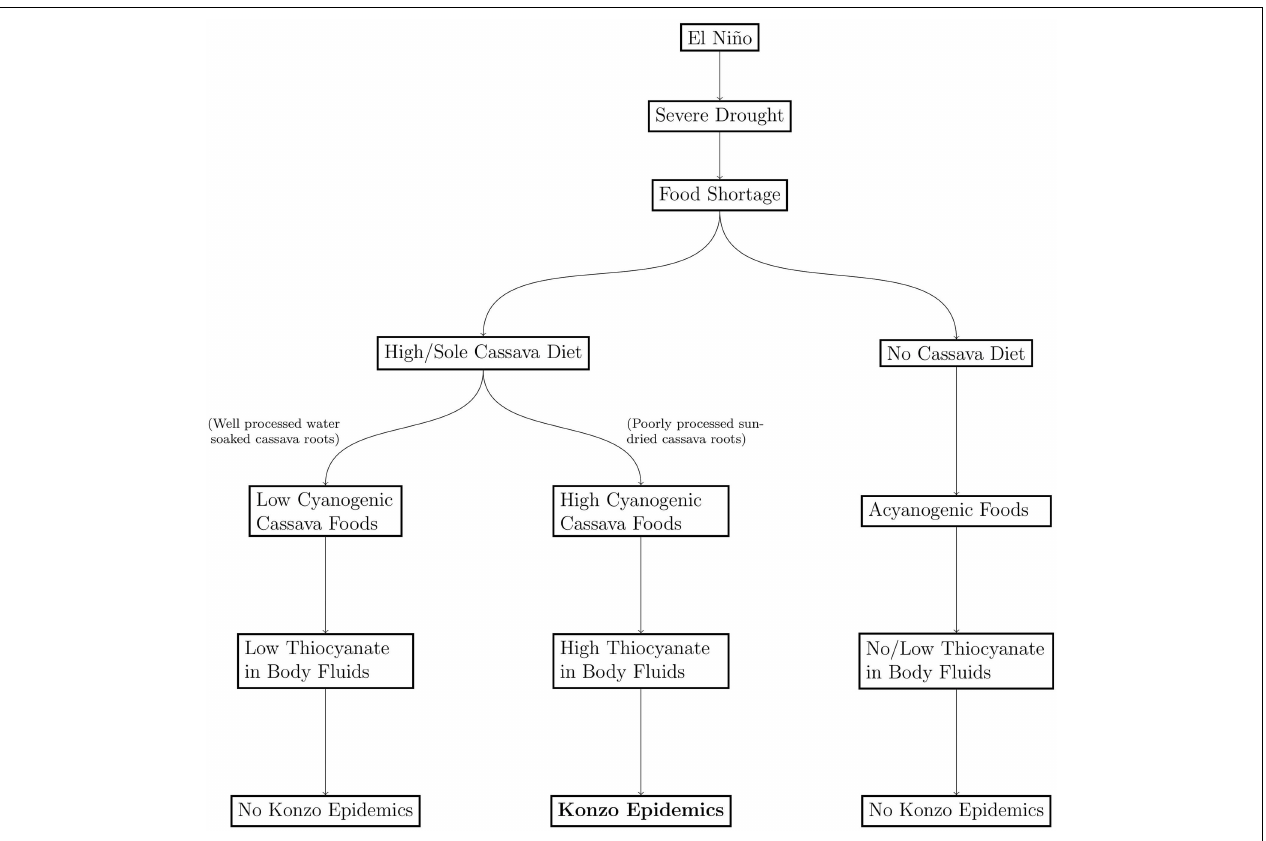
FIGURE 5 | Models of Geospatial Distribution of